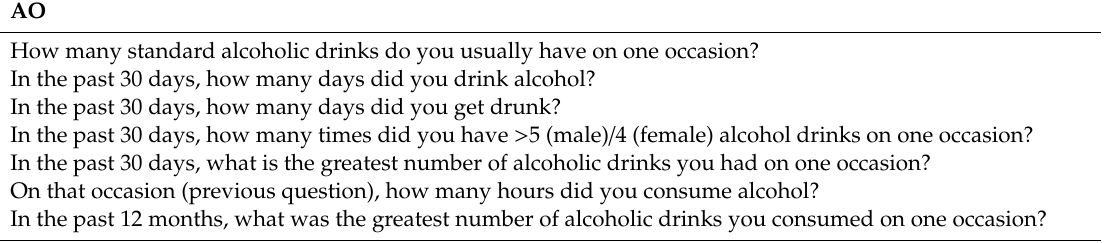
Table 1. Alcohol consumption